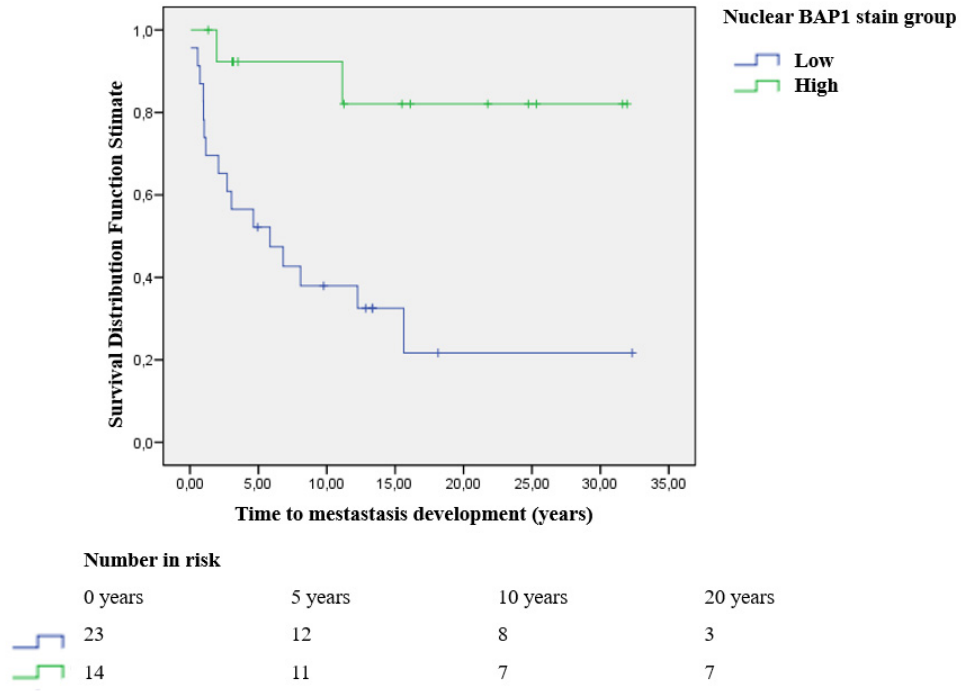
Figure 6. Kaplan–Meier metastasis-free survival curve in uveal melanoma patients with low and high grade nuclear BAP1 stain ( p =